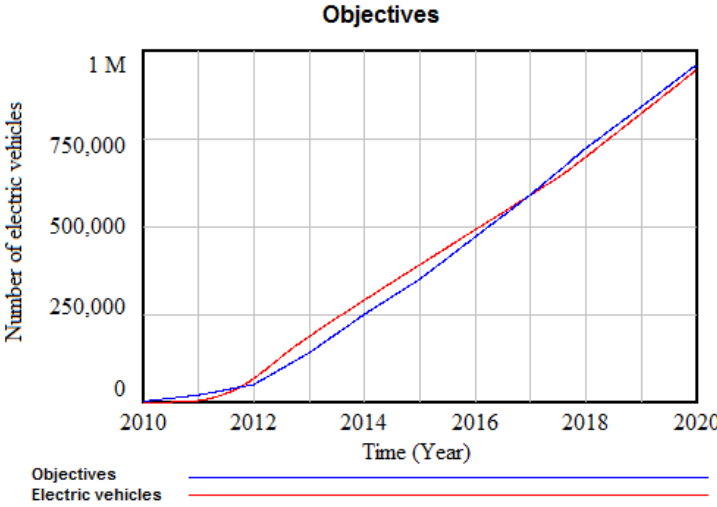
Figure 18. Electric vehicle fleet compared to the Government target for the pessimistic scenario with the optimal subsidies until 2020 (the authors’